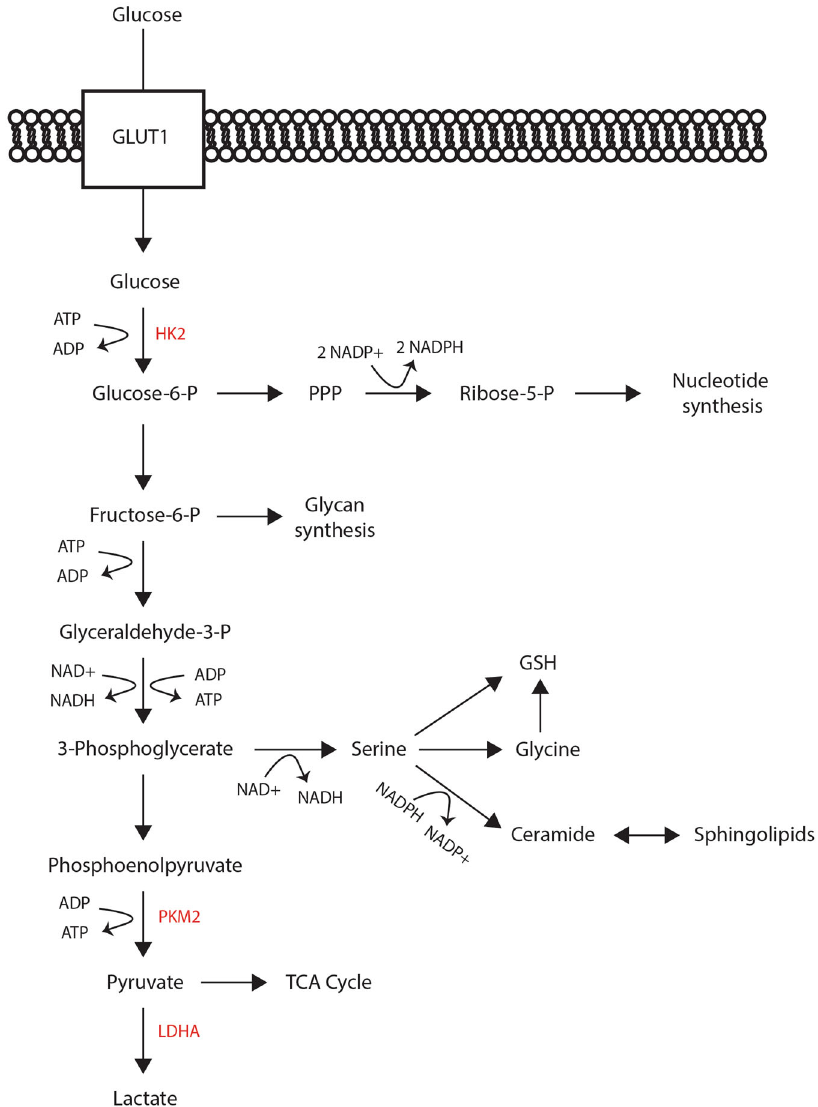
Fig. 2 Aerobic glycolysis. The molecular steps of aerobic glycolysis and the branching pathways of the pentose phosphate pathway (PPP), glycan synthesis, and serine biosynthesis. Mutated or deleted glycolytic enzymes associated with degenerative retinal phenotypes are highlighted in red (i.e., HK2, PKM2, and LDHA). Details and references for these mutations are speci fi ed in Table 1. Nicotinamide adenine dinucleotide and nicotinamide adenine dinucleotide phosphate in their reduced (NADH and NADPH) and oxidized (NAD + and NADP + ) forms and adenosine diphosphate (ADP) and adenosine triphosphate (ATP) are detailed. Glucose-6-P glucose-6-phosphate, fructose-6-P fructose-6-phosphate, glyceraldhyde-3-P glyceraldehyde 3-phosphate, GSH glutathione, HK2 hexokinase 2, PKM2 pyruvate kinase muscle isoform 2, and LDHA lactate dehydrogenase